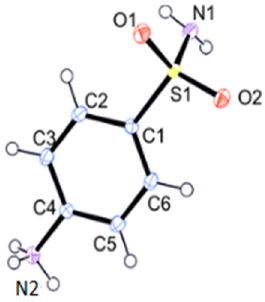
Figure 1: ORTEP diagram of Sulfanilamide.